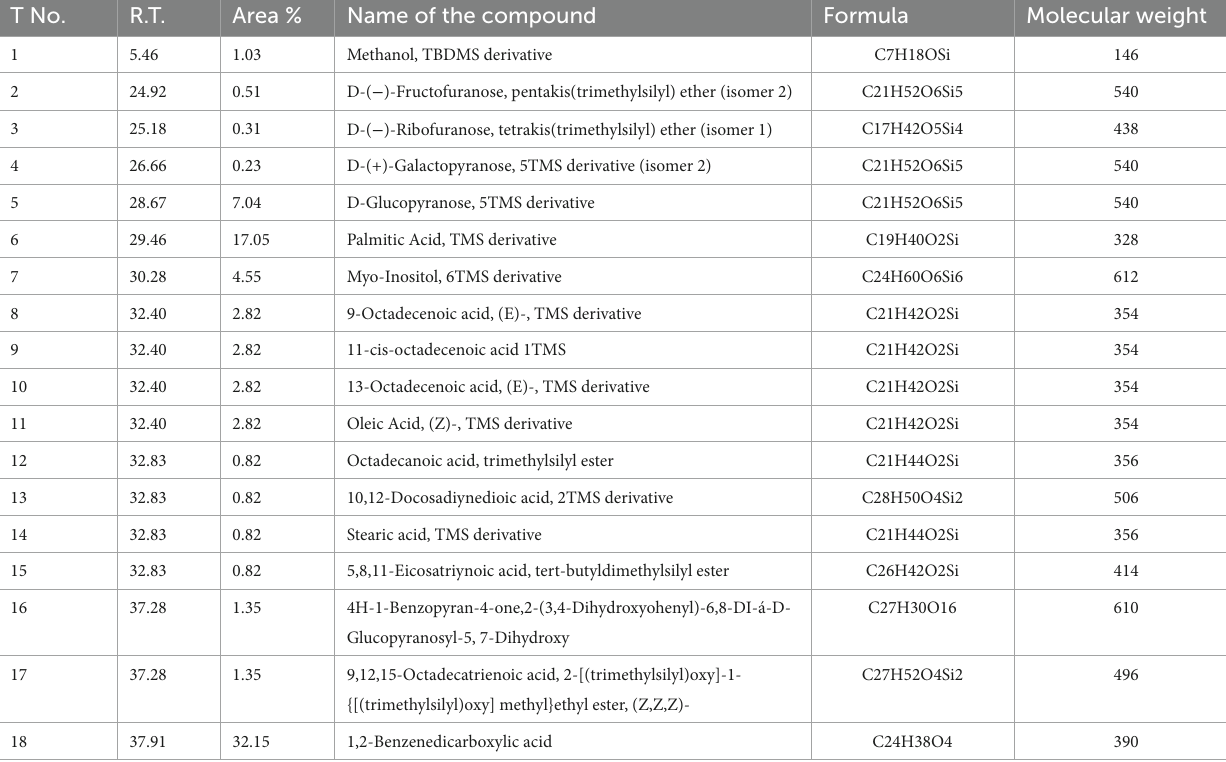
TABLE 3 Bioactive compounds identified in T. asperellum crude extract using GC–MS analysis. T